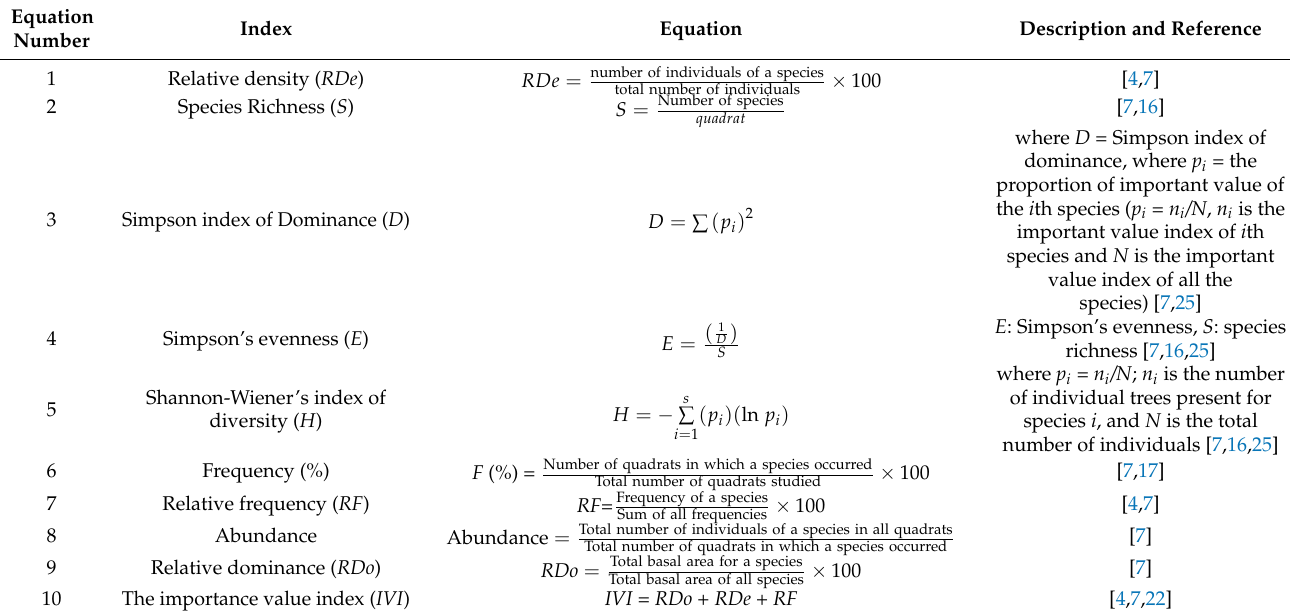
Table 1. Indices used to quantify forest structure and composition diversity. For each index, the equation used to calculate it. Its description and bibliographic references are